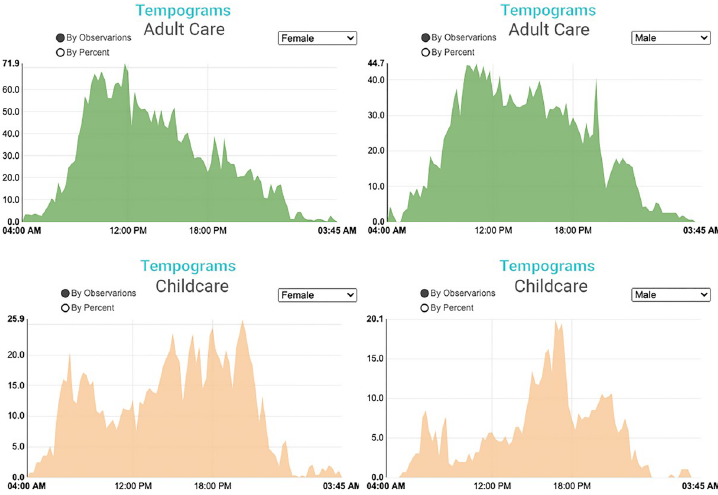
Fig 4. Adult care time use tempograms for women (top left) and men (top right) and child care for women (bottom left) and men (bottom right). Source: IPUMS ATUS Extractor: Sample of self-identified family caregivers from